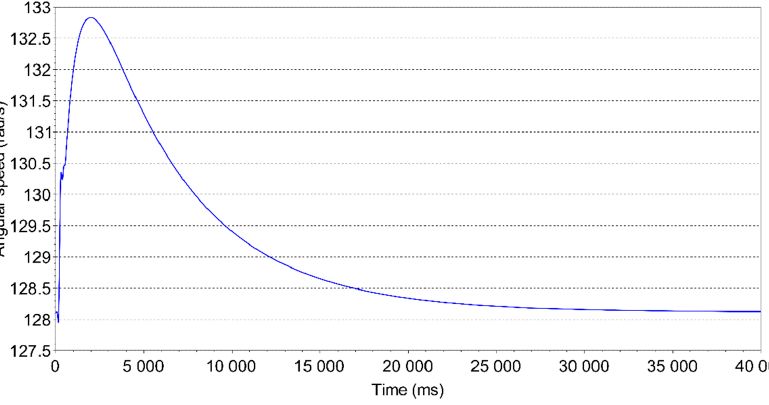
Figure 18. Armature speed for ride-through analysis .